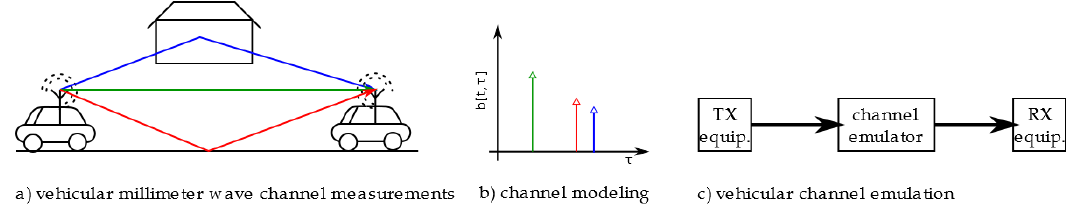
Figure 1. Necessary stages for channel emulation: ( a ) the encountered MPCs of a V2V transmission; ( b ) a simplified channel impulse response representation of ( a ); and ( c ) how a physical device applies the model from ( b ) to a signal going from Transmitter (Tx) to Receiver